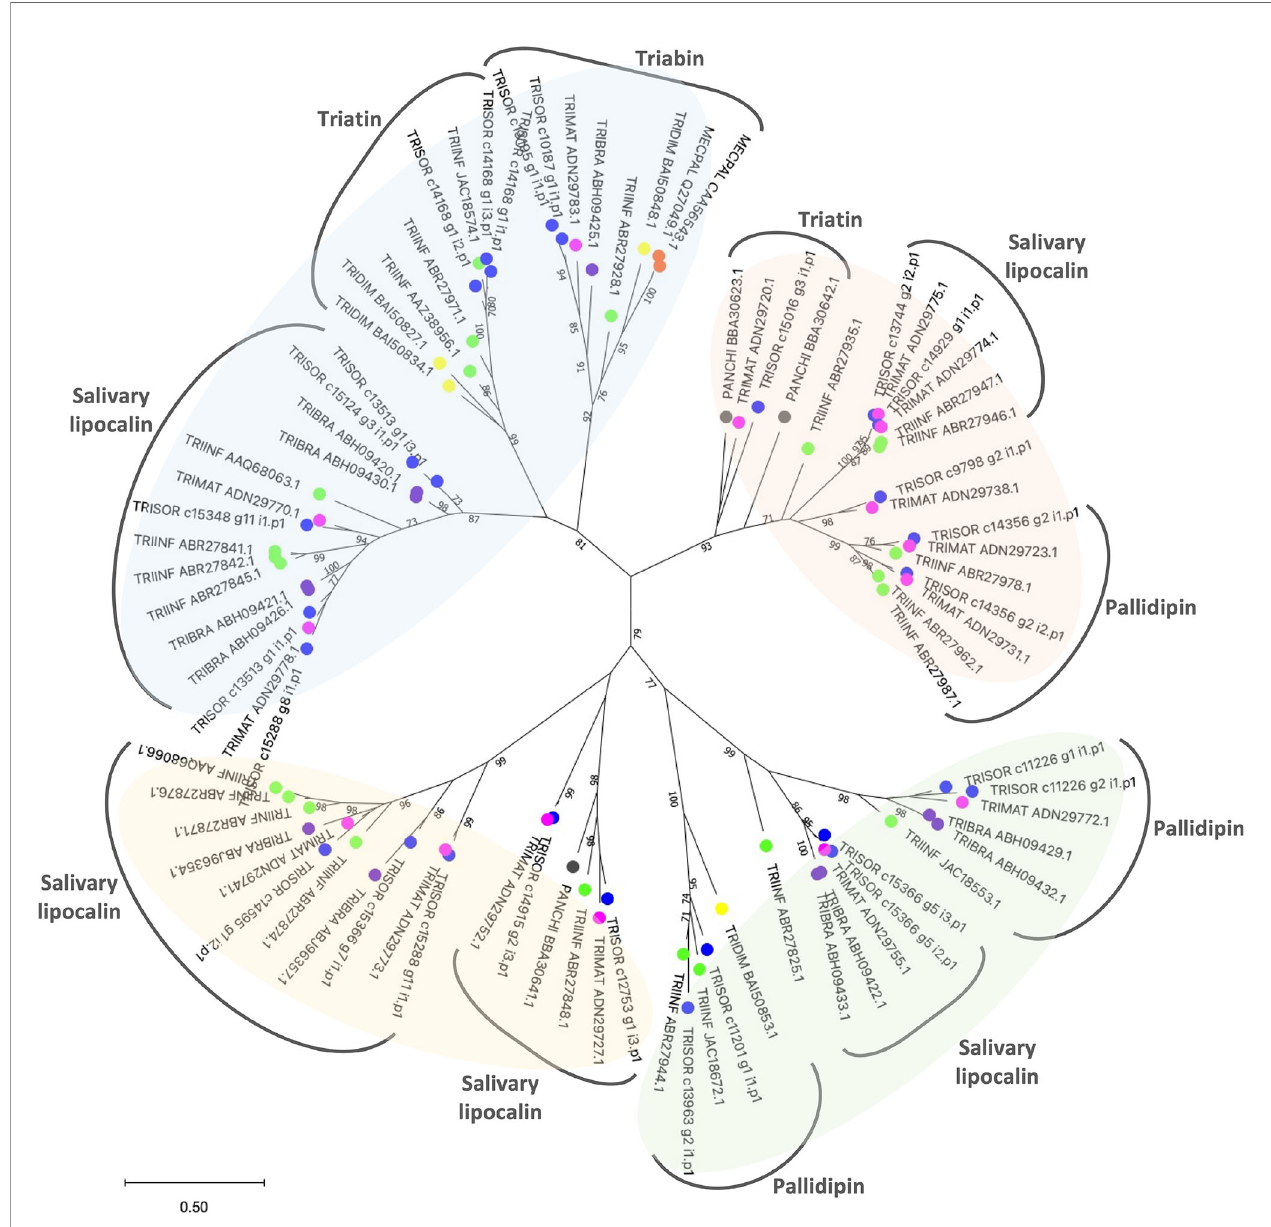
FIGURE 2 | Maximum likelihood tree with Triatoma sordida salivary lipocalins. The distance tree among lipocalin sequences is derived from the alignment of T. sordi da CDS extracted from the sialotranscriptome analysis and other lipocalin sequences from Triatominae. The amino acid sequences are identi fi ed as described in the Methods section. The coloured circles identify the species whose sequences were used: blue, T. sordida ; magenta, Triatoma matogrossensis ; purple, Triatoma brasiliensis ; green, Triatoma infestans ; yellow, Triatoma dimidiata ; grey, Panstrongylus chinai . The numbers at the nodes indicate the bootstrap values. The scale on the bottom measure evolutionary distance in substitutions per amino